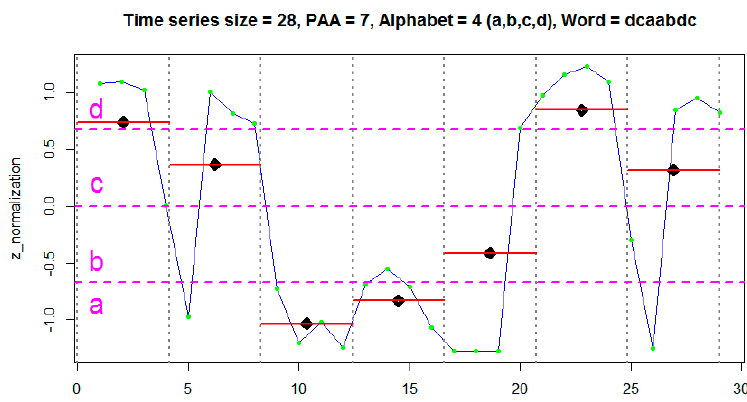
Figure 4. Example of time series discretization with SAX.